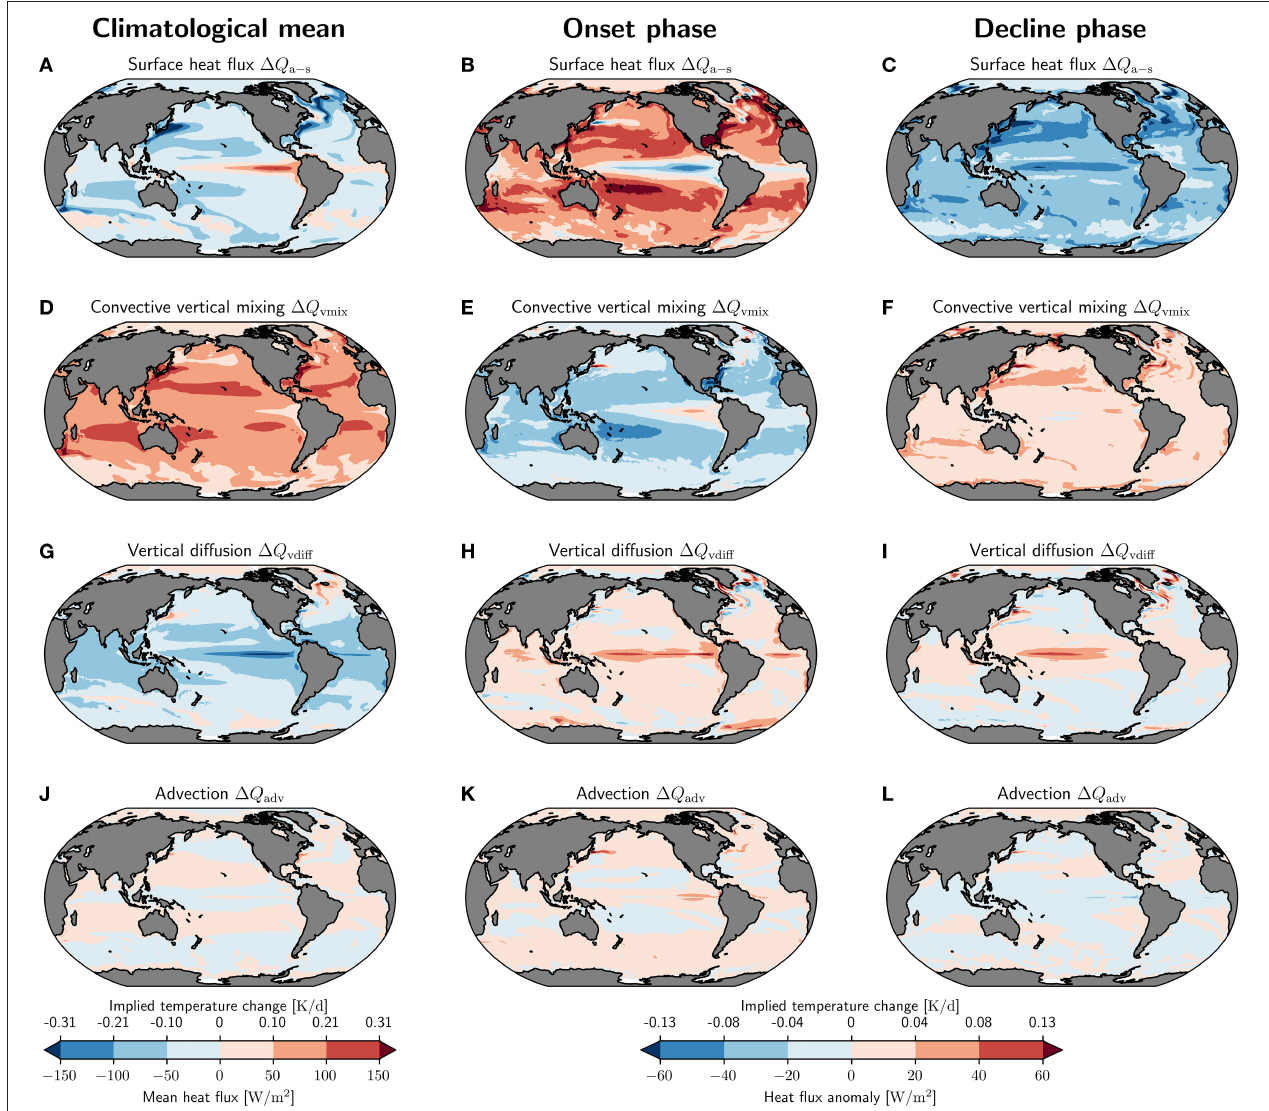
FIGURE 3 | Simulated patterns of the four most important heat and temperature tendency terms averaged over the 500-yr preindustrial control simulation [labeled as climatological mean; (A,D,G,J) ], during the onset phase of marine heatwaves (B,E,H,K) , and during the decline phase of marine heatwaves (C,F,I,L) . The patterns during the onset and decline phase were obtained by averaging daily surface tendency term anomalies of each term over all onset and decline days of marine heatwaves, respectively. Implied temperature changes (units of Kd − 1 ) were computed assuming a constant grid cell thickness, see Section